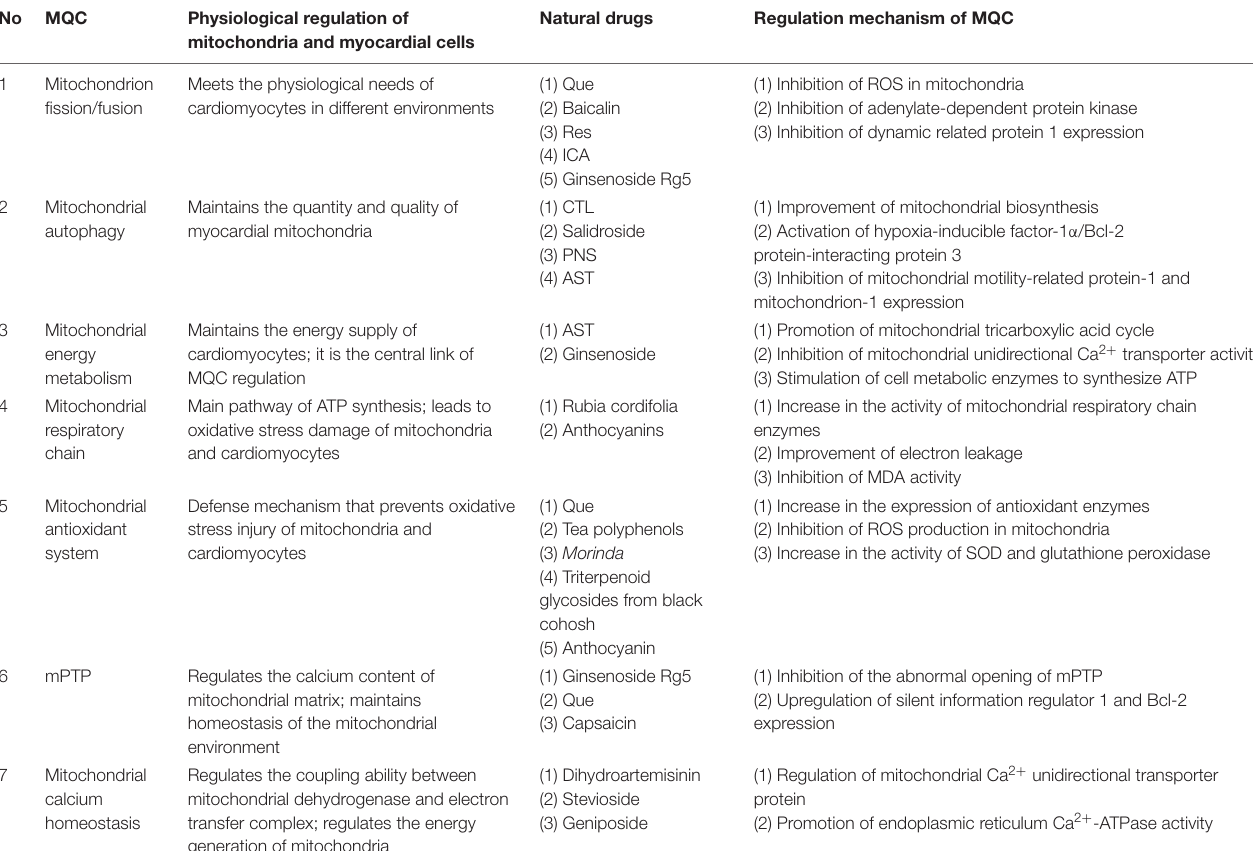
TABLE 1 | Effects of MQC on cardiomyocytes and regulatory mechanisms by natural